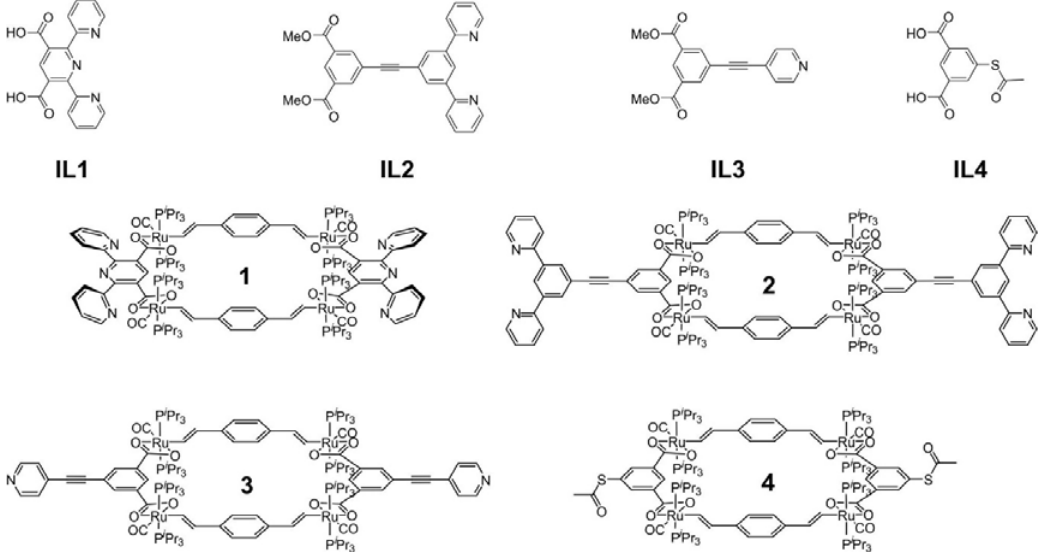
Figure 2. Ligands IL1 to IL4 and the derived tetraruthenium macrocycles 1 – 4 .